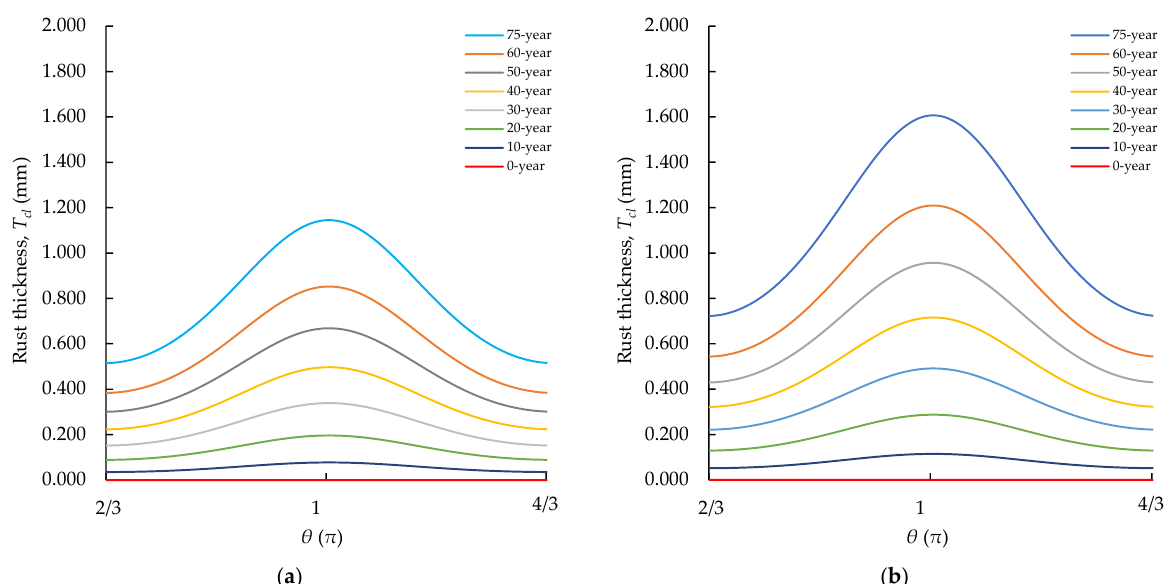
Figure 6. Nonuniform rust distribution. ( a ) PC-bar. ( b ) Transverse rebar. Figure 7 illustrates the PC-bar’s corrosion degree and corrosion rate over time. After 75 years, the corrosion degree reached 18.56%. The corrosion rate was found to decrease exponentially over time. A year after the beginning of the corrosion propagation, the corrosion rate was 1.9033 µ A/cm 2 , and it had decreased to 0.5442 µ A/cm 2 at 75 years later. Figure 8 shows volumetric strain expansion in the model representing the 75-year rust expansion. The maximum strain expansions of the PC-bar and transverse rebar in the 75 years were 1.1448 mm and 1.6061 mm, respectively.